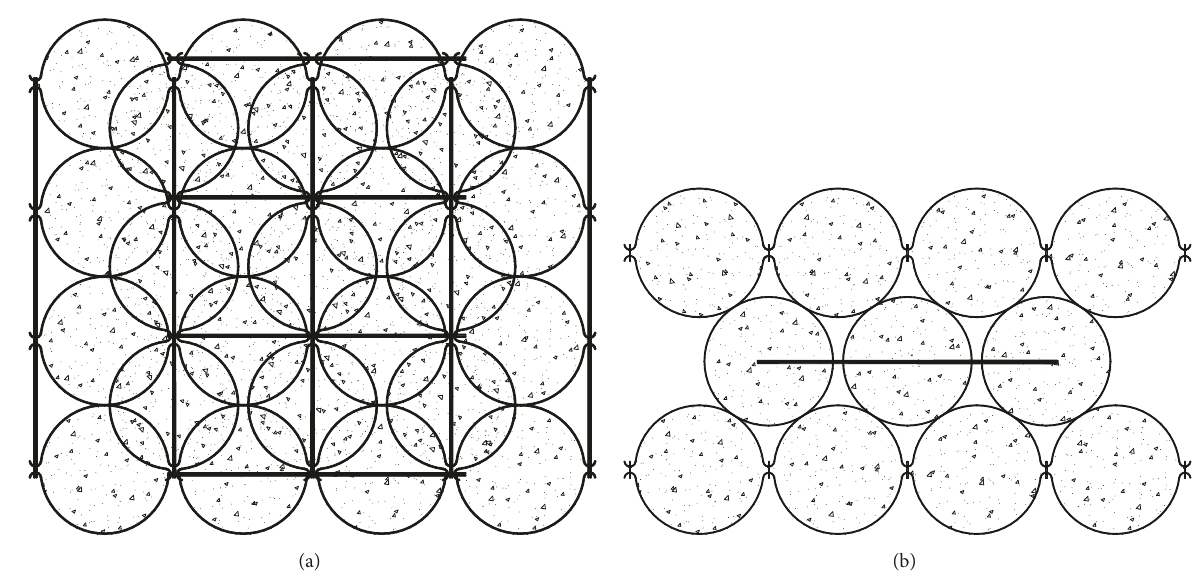
Figure 2: Structural scheme of multiple soil net layer, (a) top view and (b) front